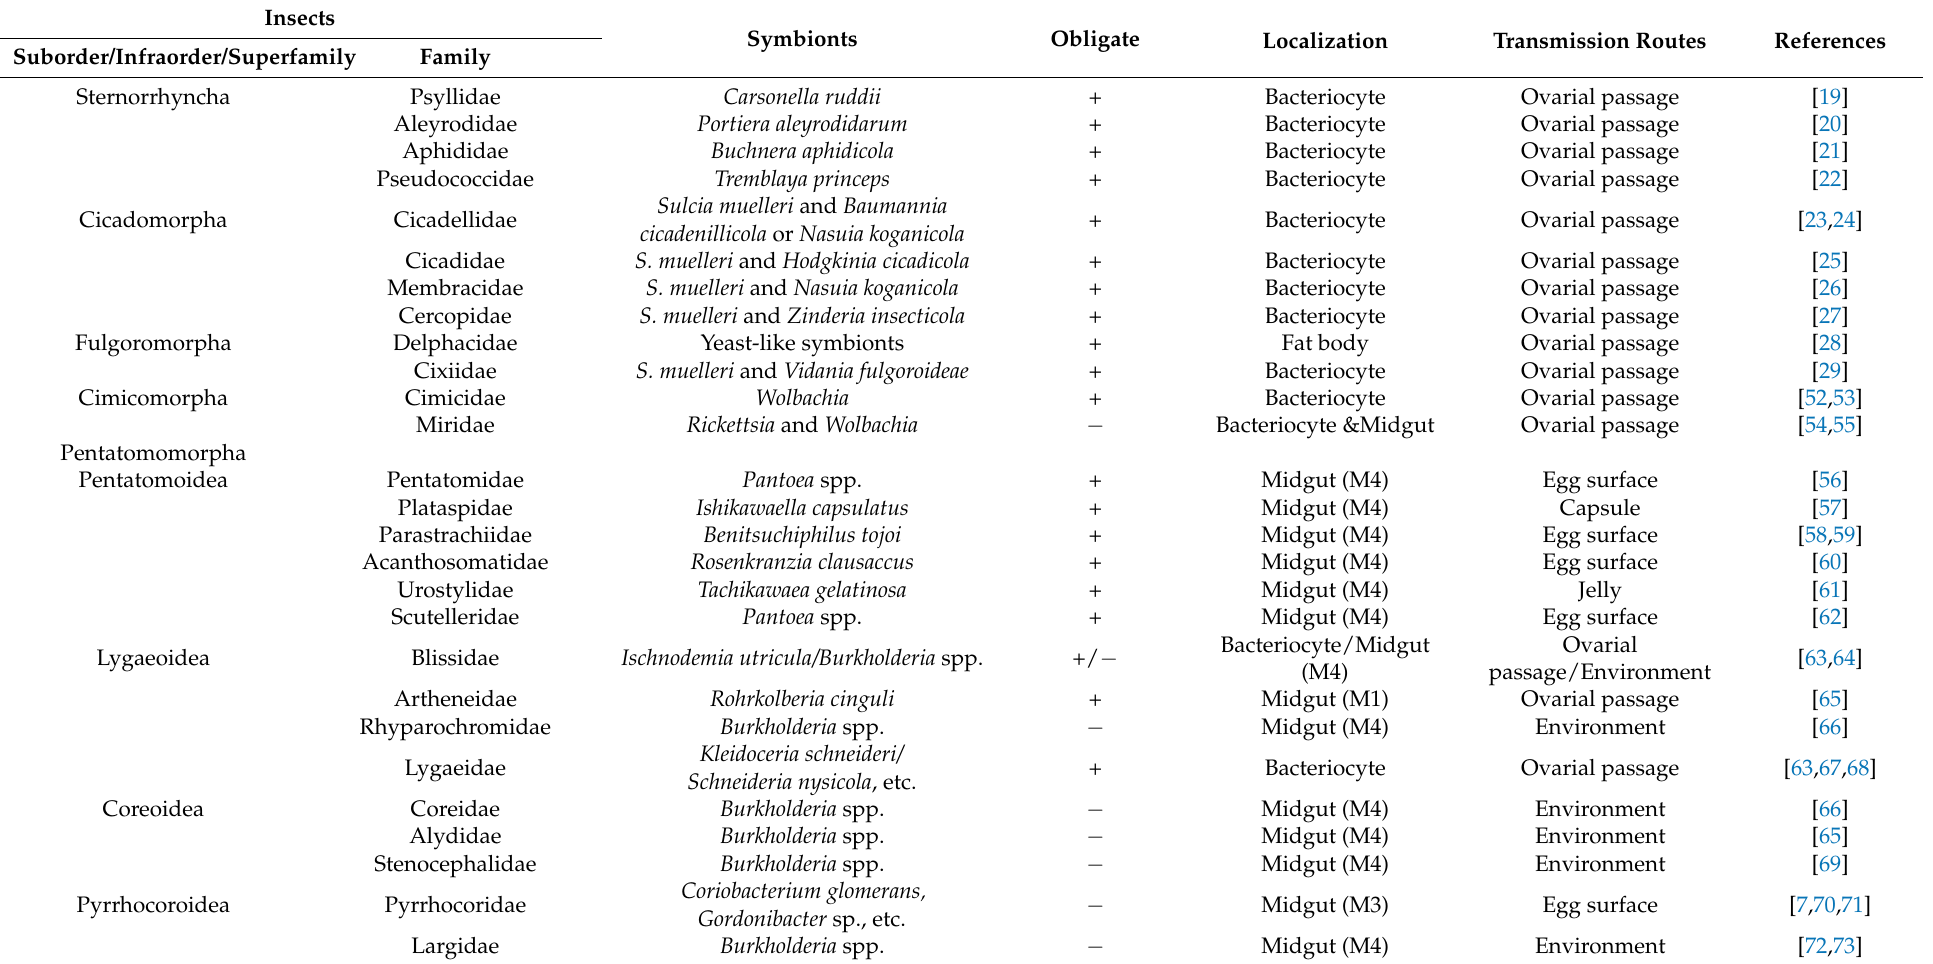
Table 1. The nutrient related symbionts and their localizations in symbiotic organs of representative the hemipteran